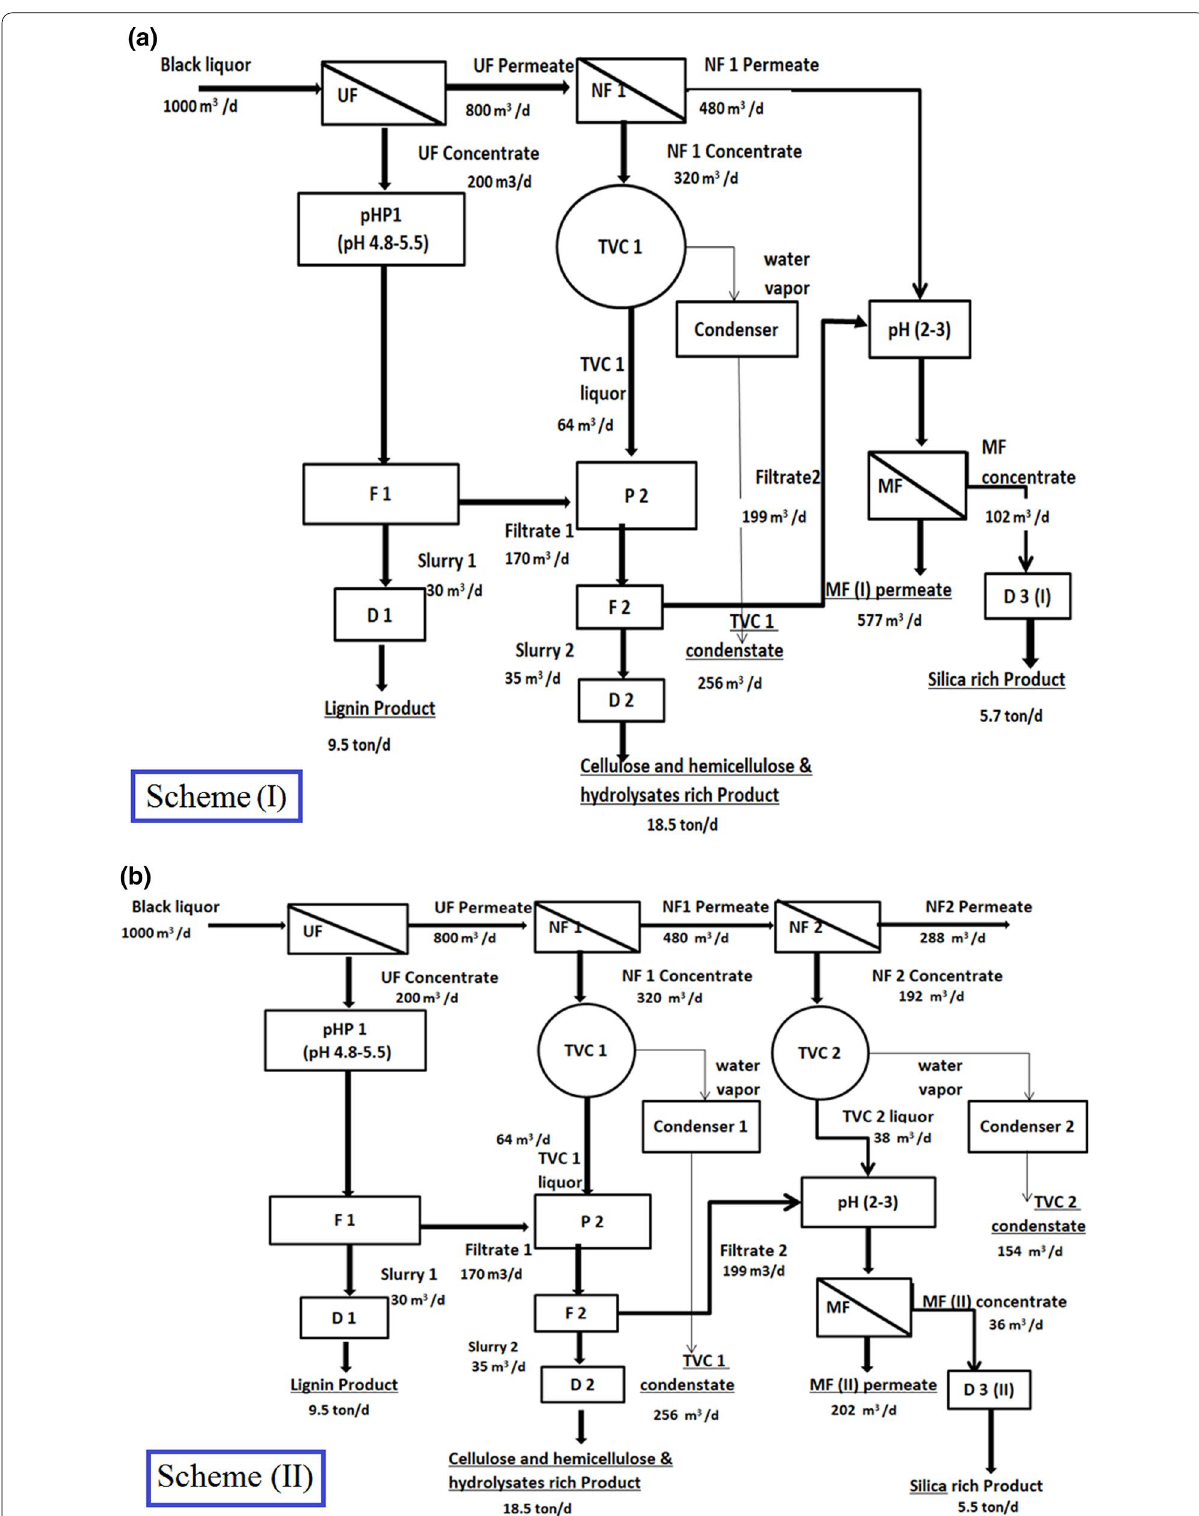
Fig. 1 Developed schemes (I) and (II) for byproducts recovery from rice straw black